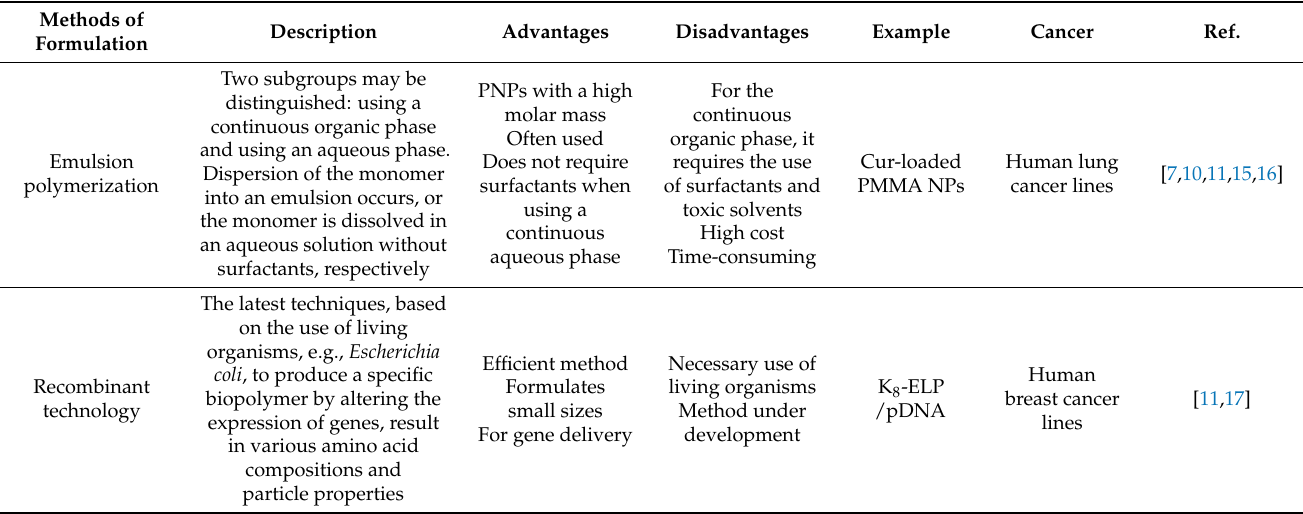
Table 1. Bottom-up techniques for formulation of polymeric